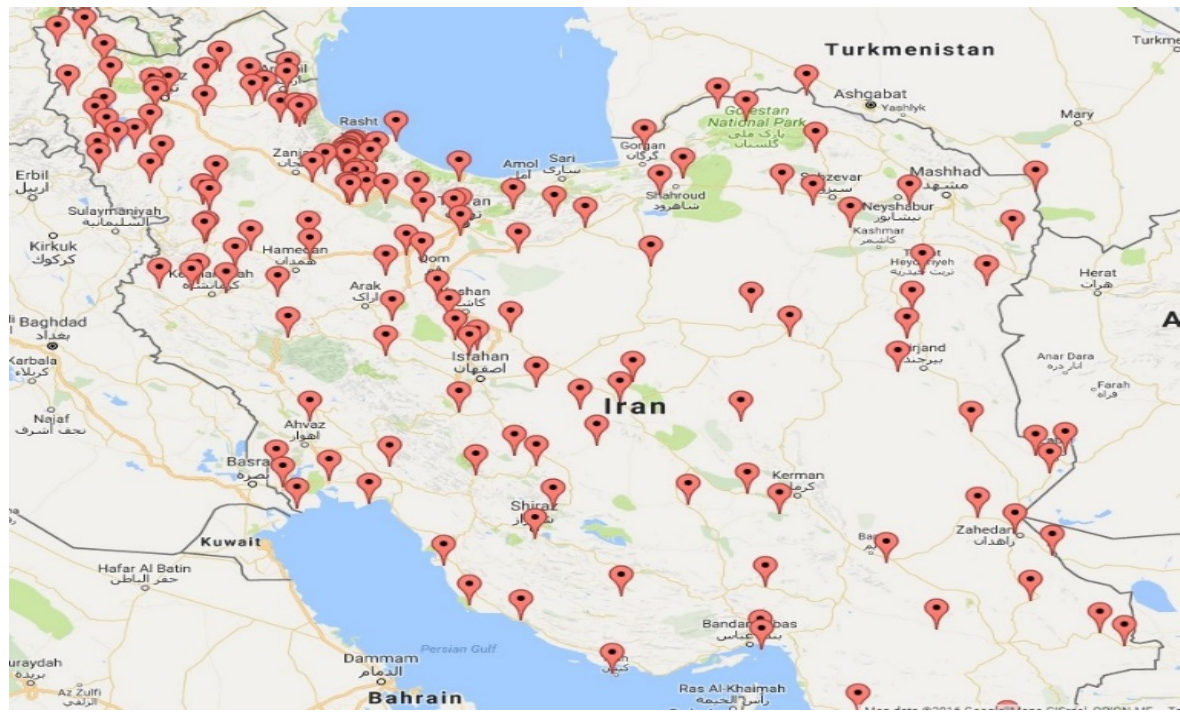
Figure 1. Geographical locations of SATBA wind data loggers . Source: SATBA.